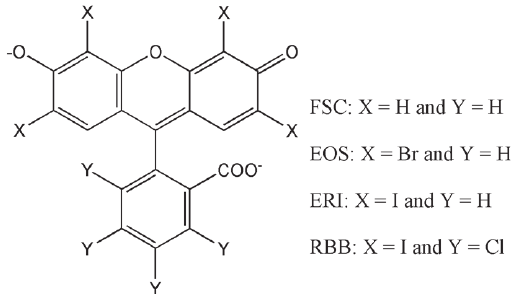
Figure 1 - Xanthene dyes